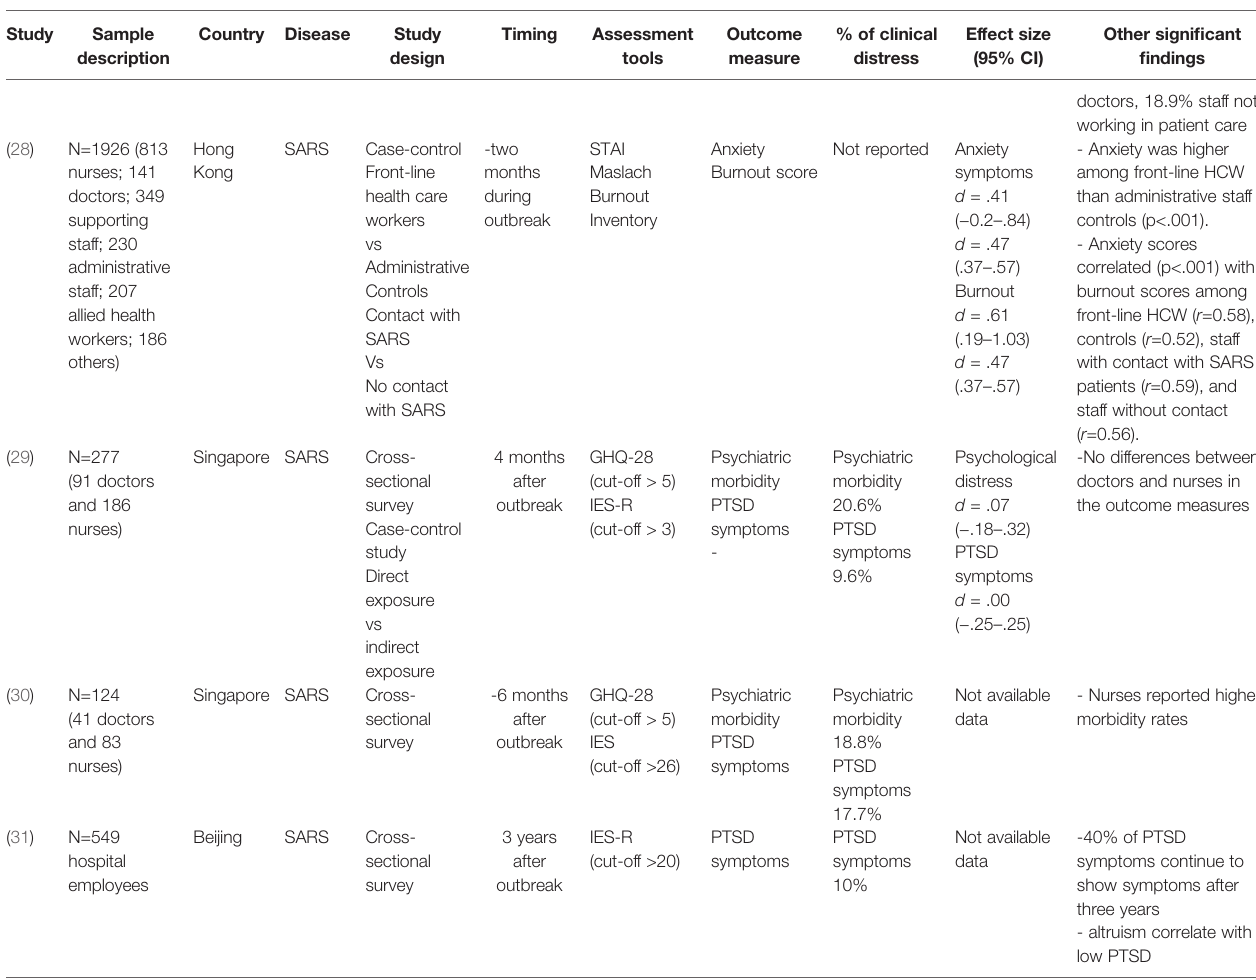
Table 2 . Data are drawn from survey with voluntary and anonymous participation with a response rate ranging